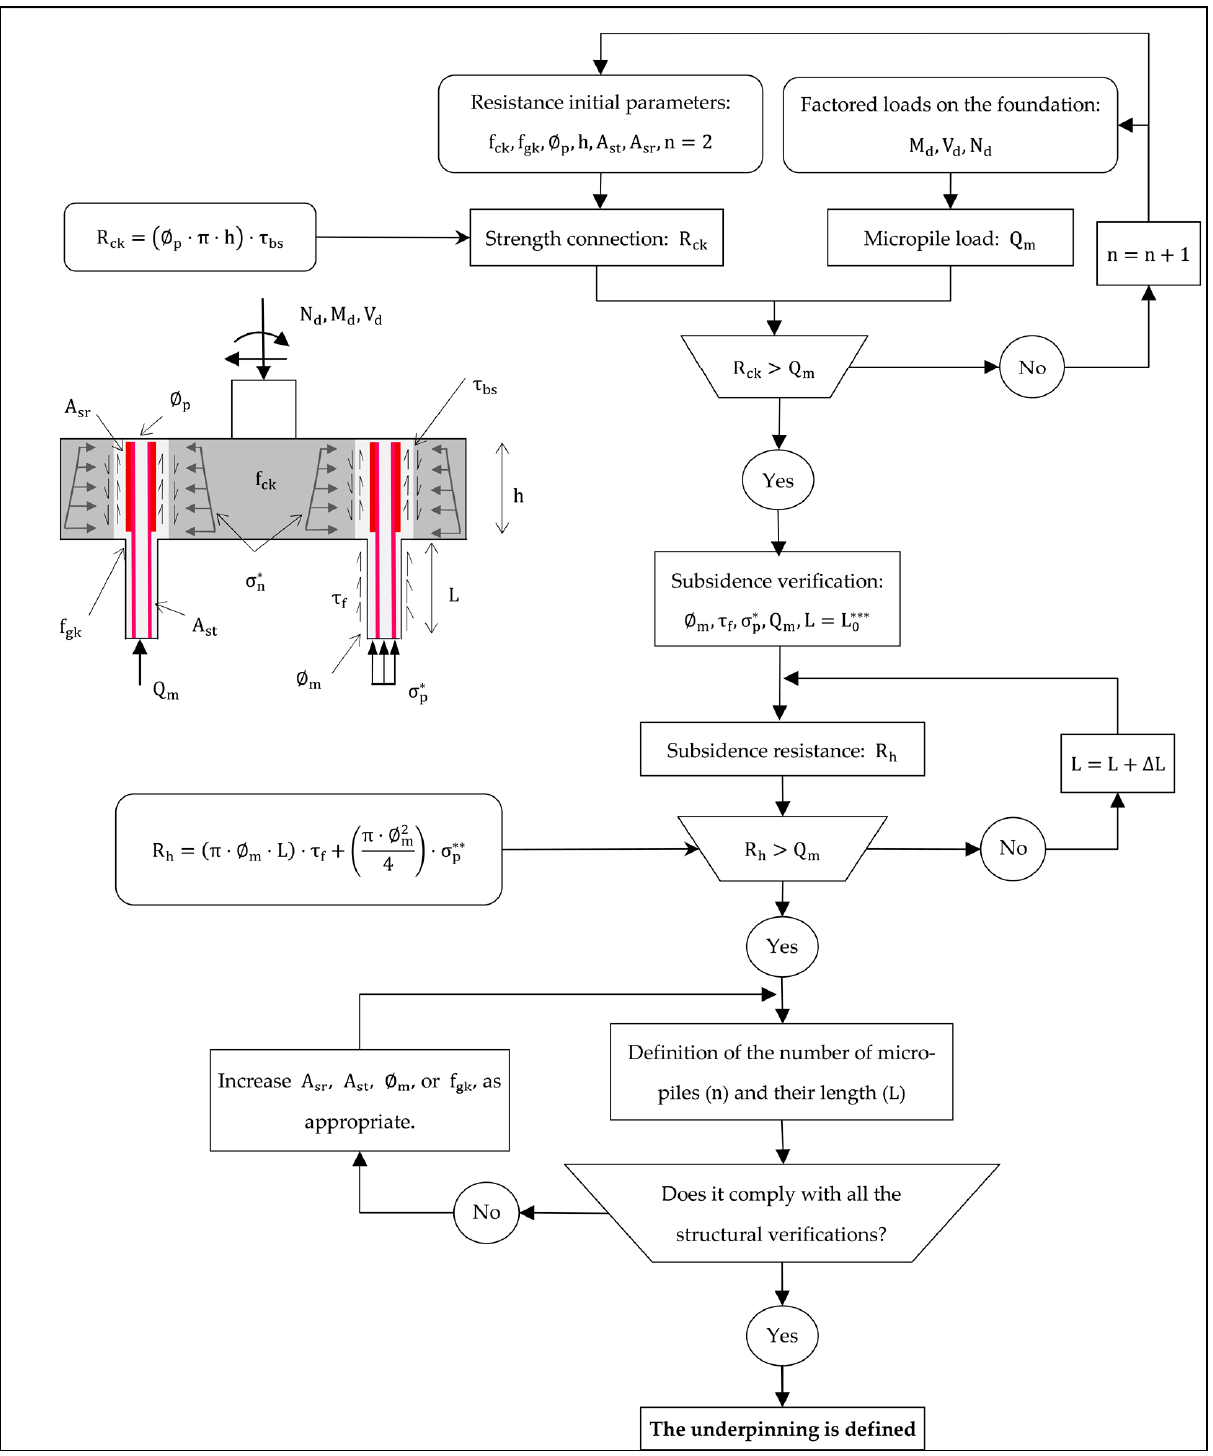
Figure 1. Flow diagram for the design of building underpinnings through micropiles. * Radial compressive stress ( σ n ) according to G ó mez et al. [15], but it is neglected. ** It is included in the algorithm flow diagram, but it has not been considered in the calculations ( σ (cid:2926) = 0) . *** The length variable starts with L 0 = 0 m. This length increases until the soil bearing capacity is complied.